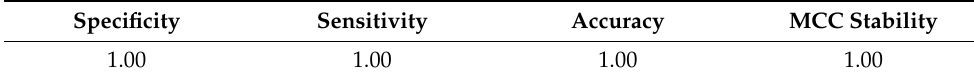
Table 2. Training accuracy results through self-consistency test.